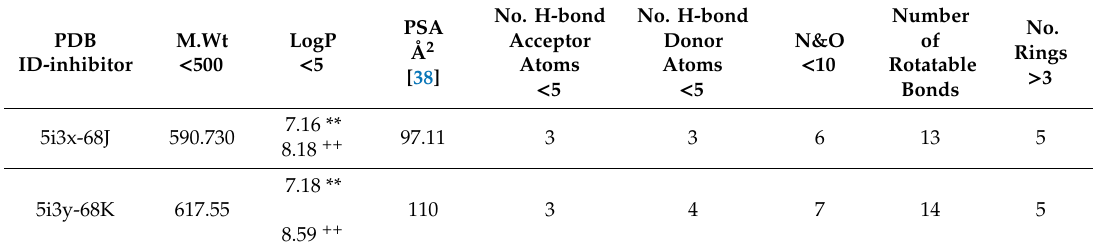
Table 7. Drug likeness parameters for inhibitors under study (all rules are included).